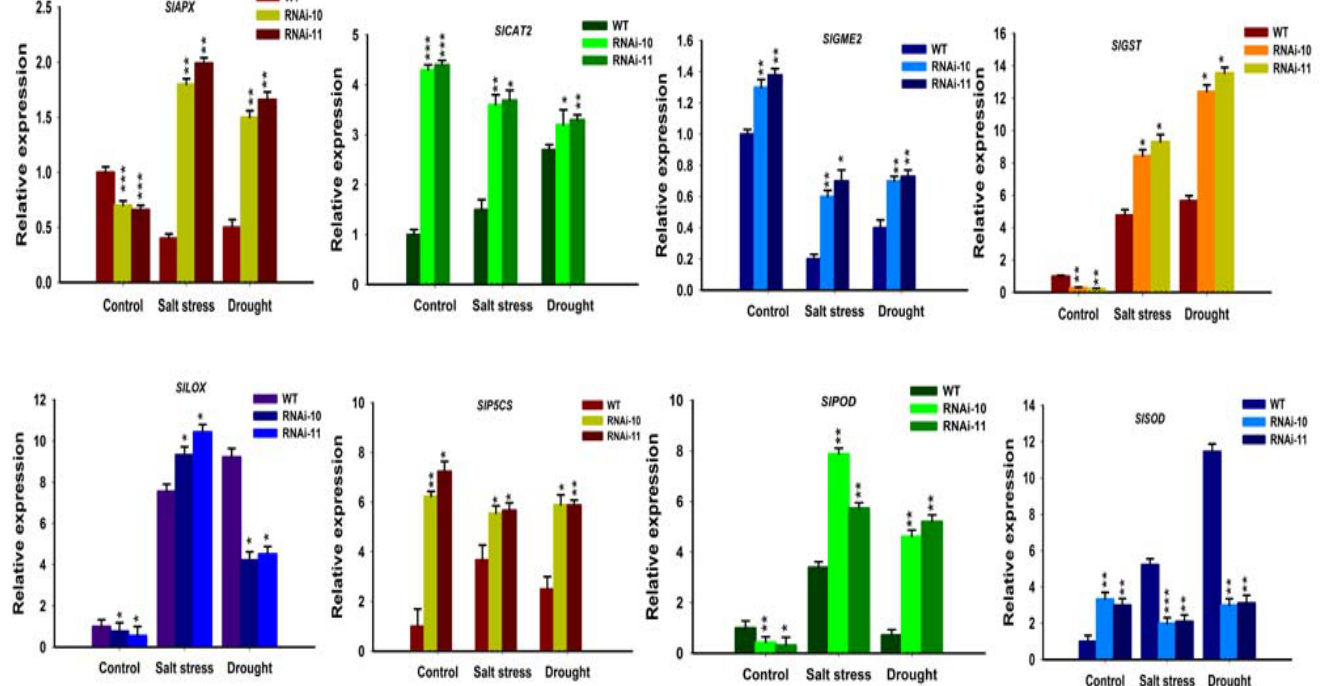
Figure 12. Expression analysis of ROS Scavenging related genes. Expression analysis of stress-related genes ( SlAPX , SlCAT2 , SlGME2 , SlGST , SlLOX , SlP5CS , SlPOD , and SlSOD ) in SlGRAS10 -RNAi (L10, L11) and WT under control, salt and drought stresses. The date represents the mean ± SE of three independent replicates. *, **, *** indicates a significant difference ( p < 0.05, p < 0.01, p < 0.001) between transgenic and wild-type plants.